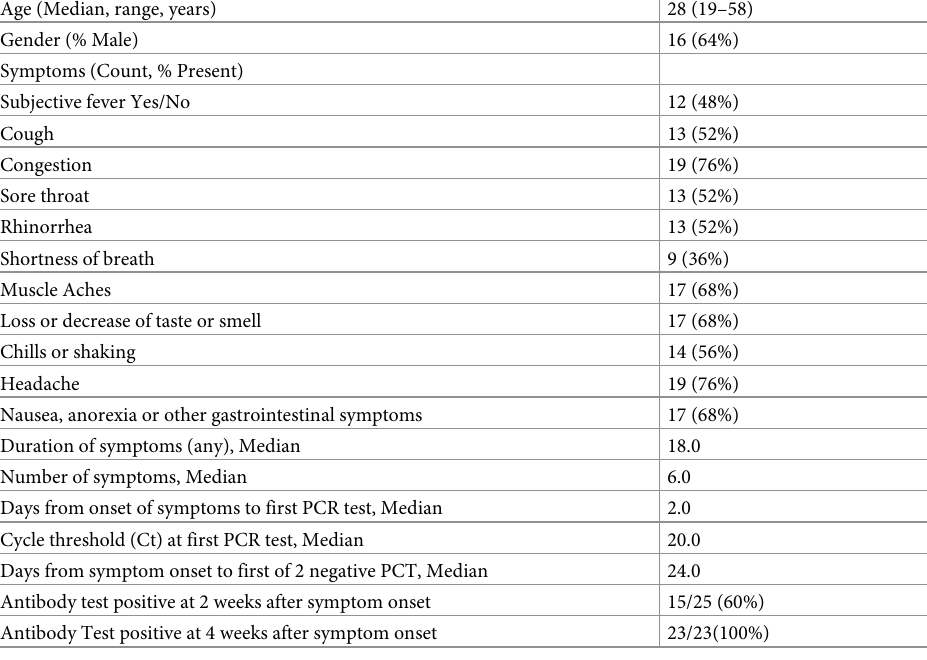
Table 1. Clinical characteristics of 25 patients with mild or moderate